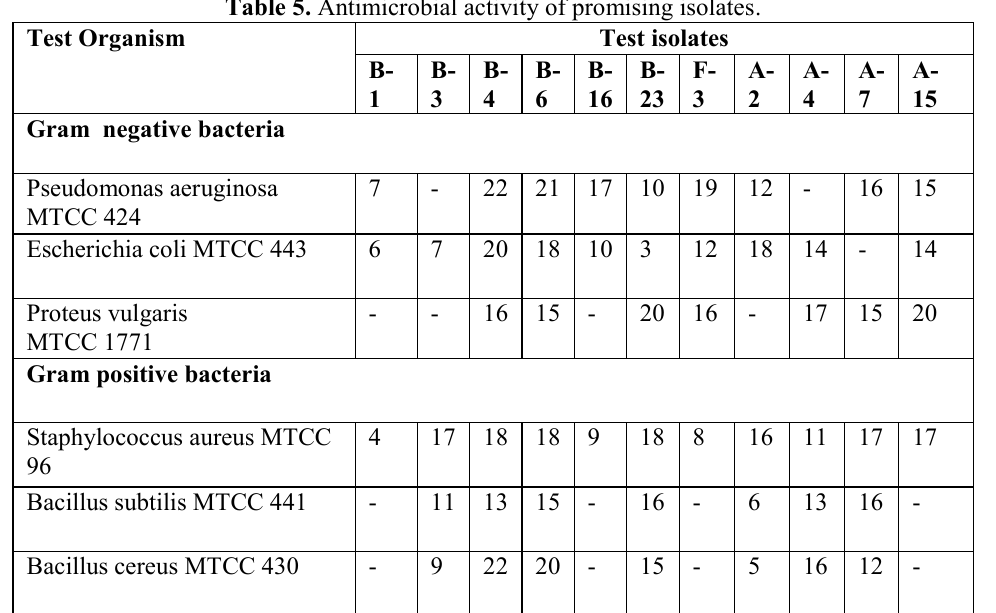
Table 5. Antimicrobial activity of promising